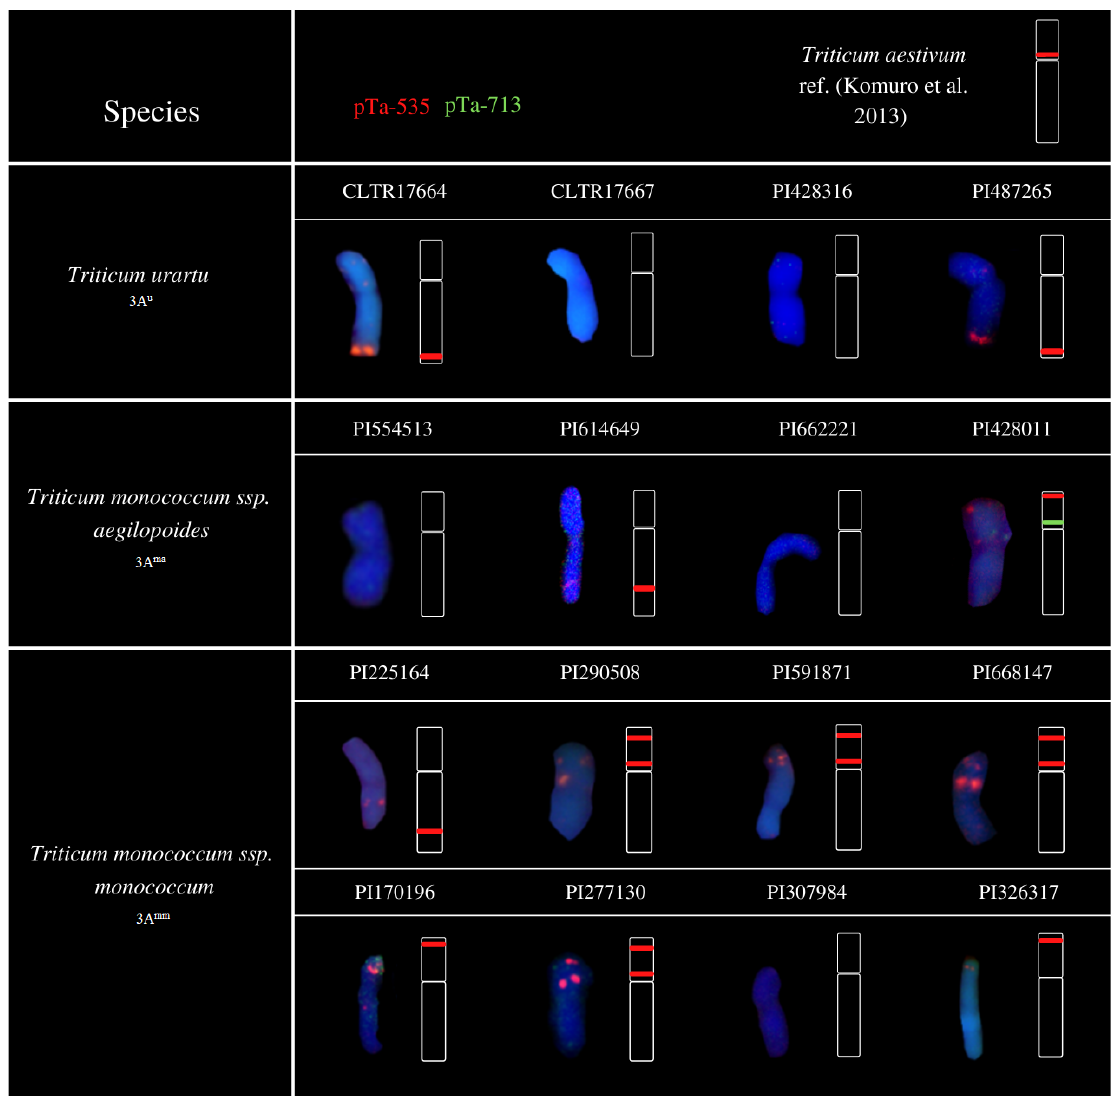
Figure 1. Chromosomes 3A after FISH with pTa -713 ( green ) and pTa-535 ( red ) probes of CLTR17664, CLTR17667, PI428316, PI487265, PI554513, PI614649, PI662221, PI428011, PI225164, PI290508, PI591871, PI668147, PI170196, PI277130, PI307984, and PI326317